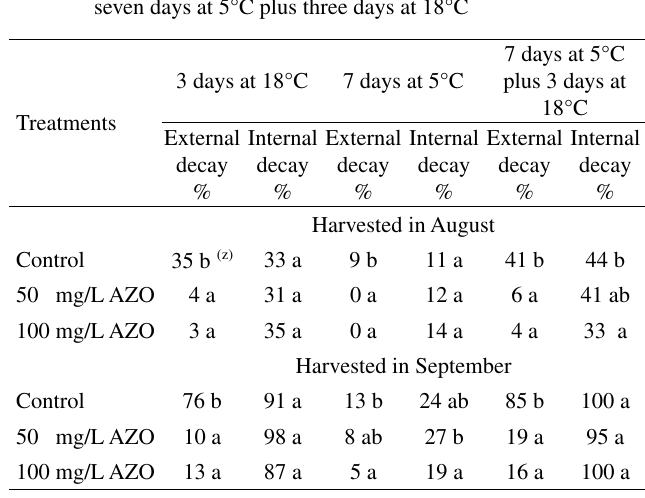
(z) For each storage period and harvesting time values in columns fol- lowed by different letters are significantly different at P≤0.05 accord- ing to Fisher’s test of the least significant difference .